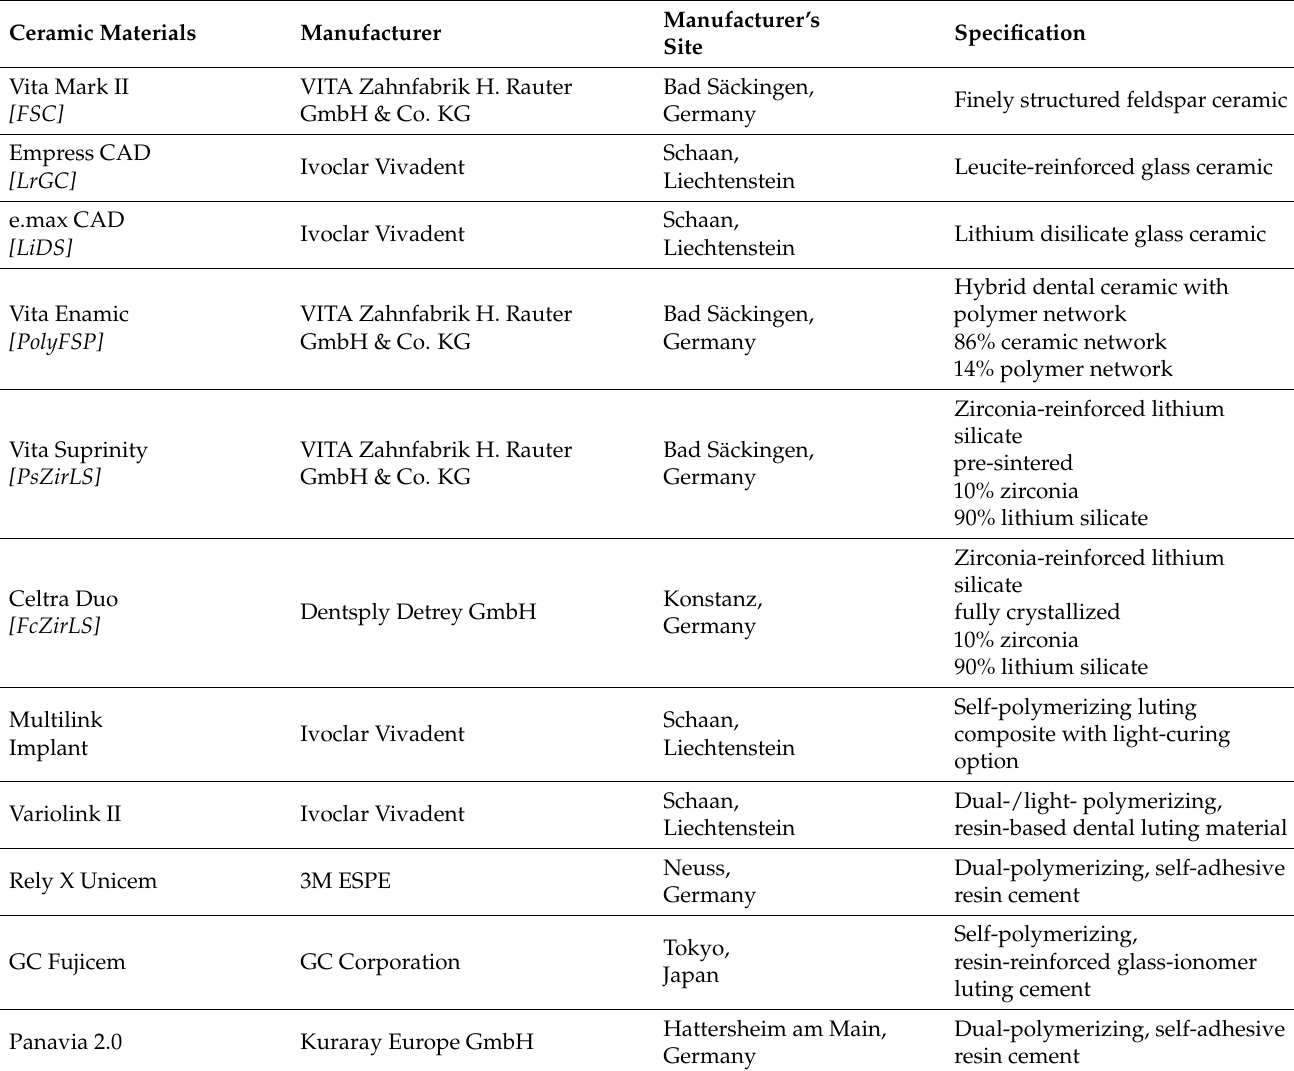
Table 1. Ceramic materials and luting agents tested in this